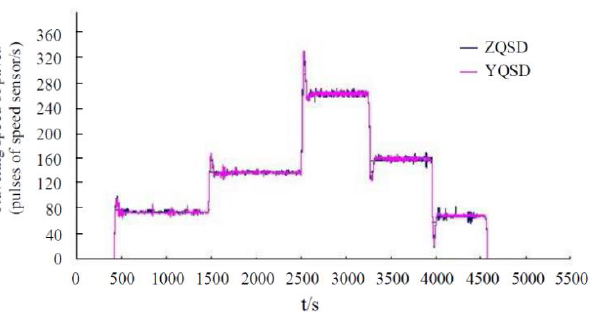
Figure 8. Constant speed test of the paver with the new control scheme when speed changes. ZQSD — Speed of the left wheel, and YQSD — speed of the right wheel.